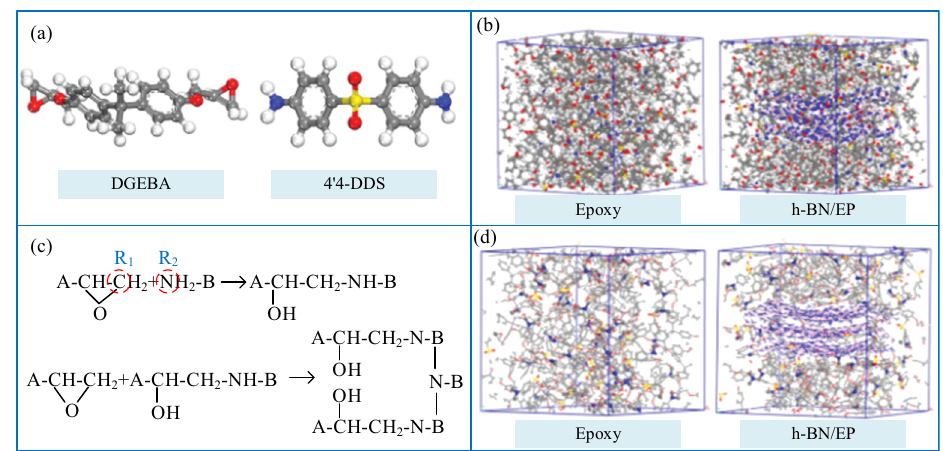
Figure 2: ( a ) Molecular models of DGEBA and 4,4 ′ - DDS. ( b ) Pure EP model and h - BN/EP model before crosslink. ( c ) Crosslink reaction process of EP. ( d ) Pure EP model and h - BN/EP model after crosslink reaction.